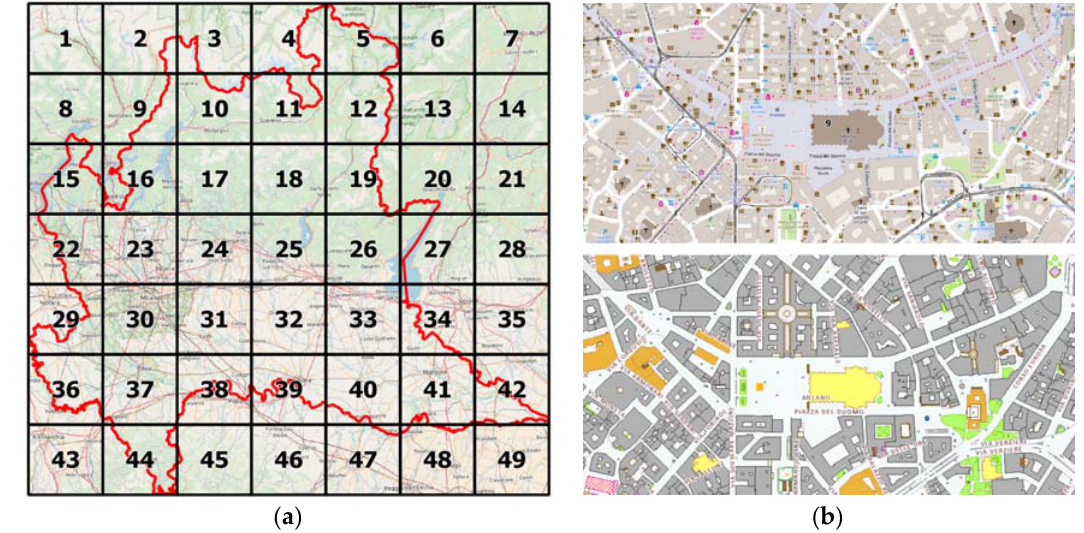
Figure 4. ( a ) The regular grid used to analyze the Lombardy region delimited by red line; ( b ) one example of the OSM map ( up ) and the DBT map ( bottom ) of the same place.